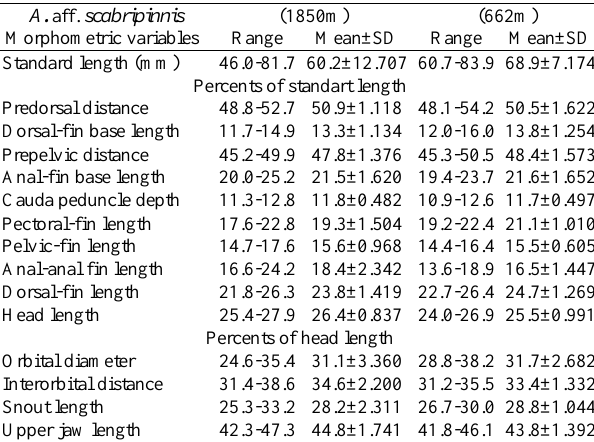
Table 1 . Weight of variables, eigenvalue and percentage of total variance of the first two axes of the principal component analysis. The second axis was subjected to shear procedure.